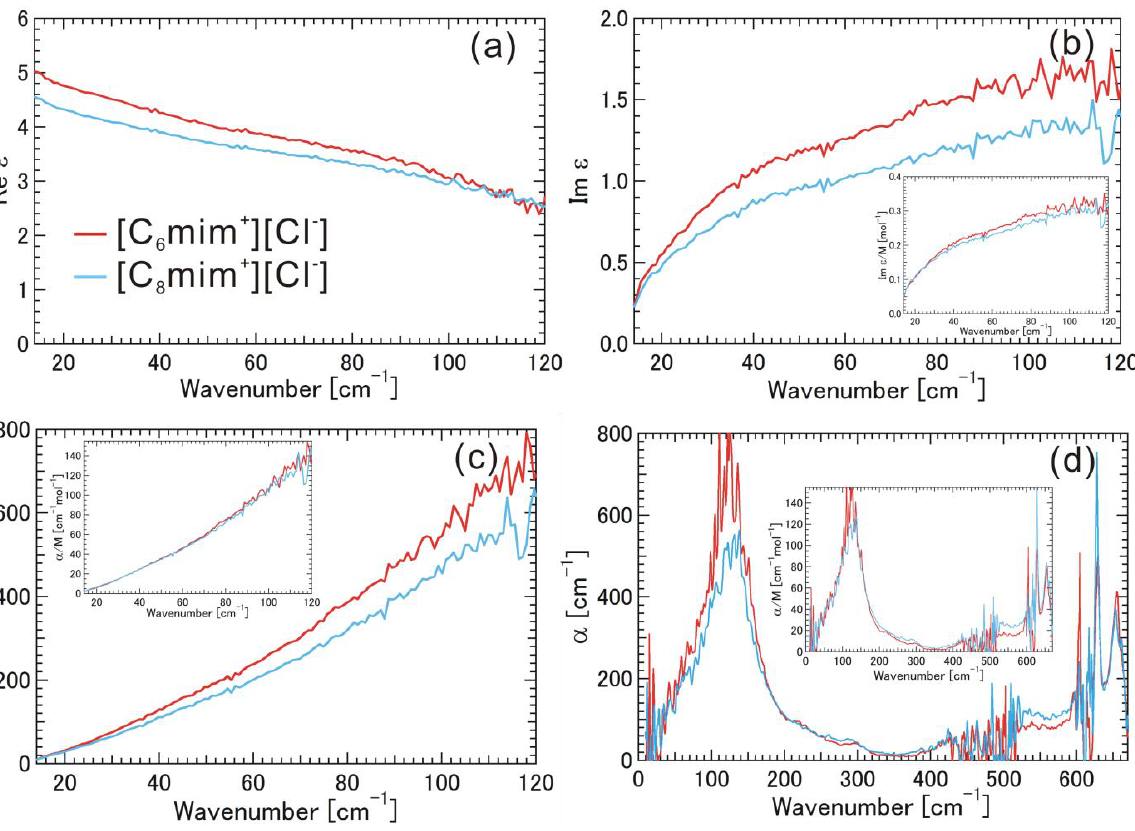
Figure 4. ( a ) Real part of the complex dielectric spectra (Re ε); ( b ) Imaginary part of the complex dielectric spectra (Im ε); ( c ) Absorption coefficients (α) obtained by THz-TDS; and ( d ) Absorption coefficients (α) obtained by FIR, for the ionic liquids [C 6 mim + ][Cl − ], [C 8 mim + ][Cl − ]. The imaginary part of the complex dielectric spectra (Im ε/M) and the absorption coefficient (α/M) normalized by molar concentration are also shown in the